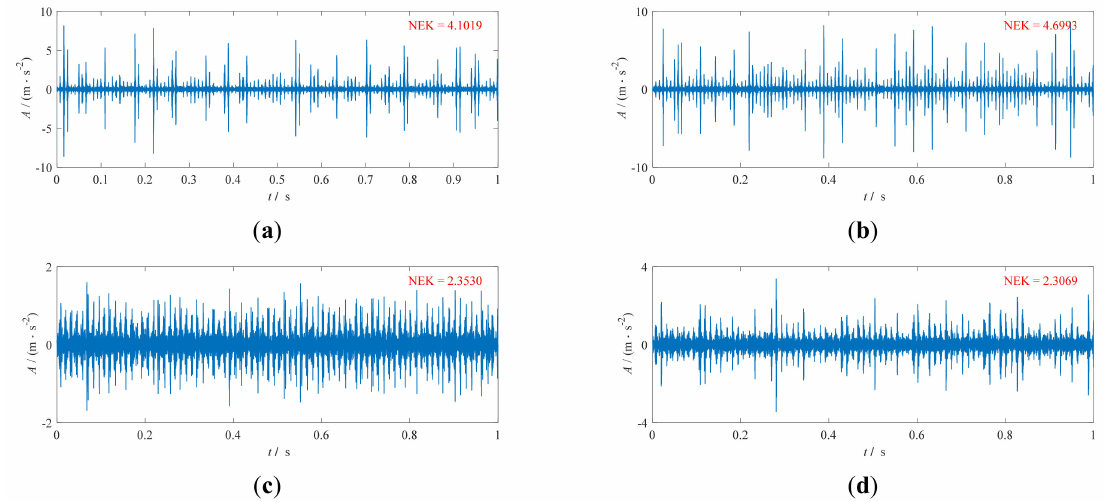
Figure 8. Results by the RVMD for the signals from MFPT: ( a , b ) correspond to the first and second sub-modes of the inner race fault bearing; ( c , d ) correspond to the first and second sub-modes of the outer race fault bearing.